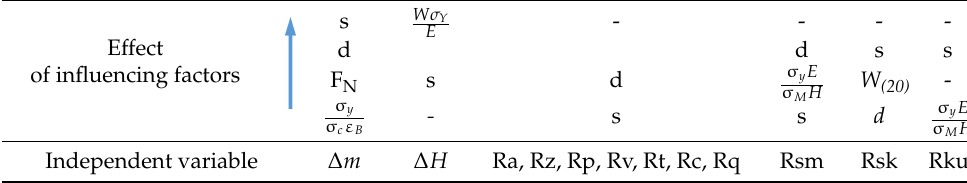
Table 17. Abrasive sensitivity ranking to pin-on-disc test system